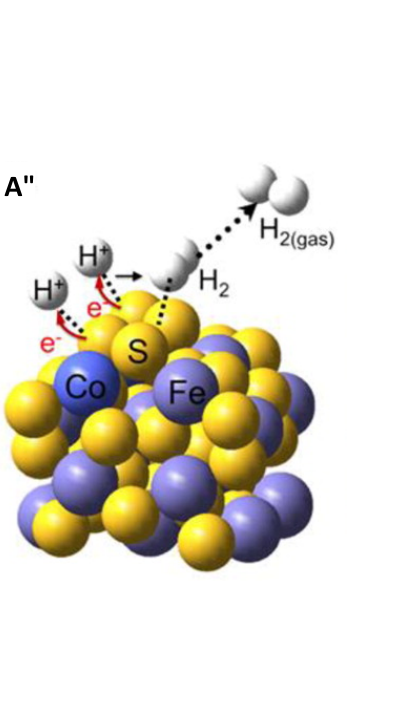
Figure 7. ( A ) Schematic reaction of hydrogen evolution occurring on a sulfur atom of Fe 0.9 Co 0.1 S 2 . ( B ) Kinetic energy barrier profiles of HER on Fe 0.9 Co 0.1 S 2 -CNT (top) and FeS 2 -CNT (bottom) catalysts. Reprinted with permission from reference [81].